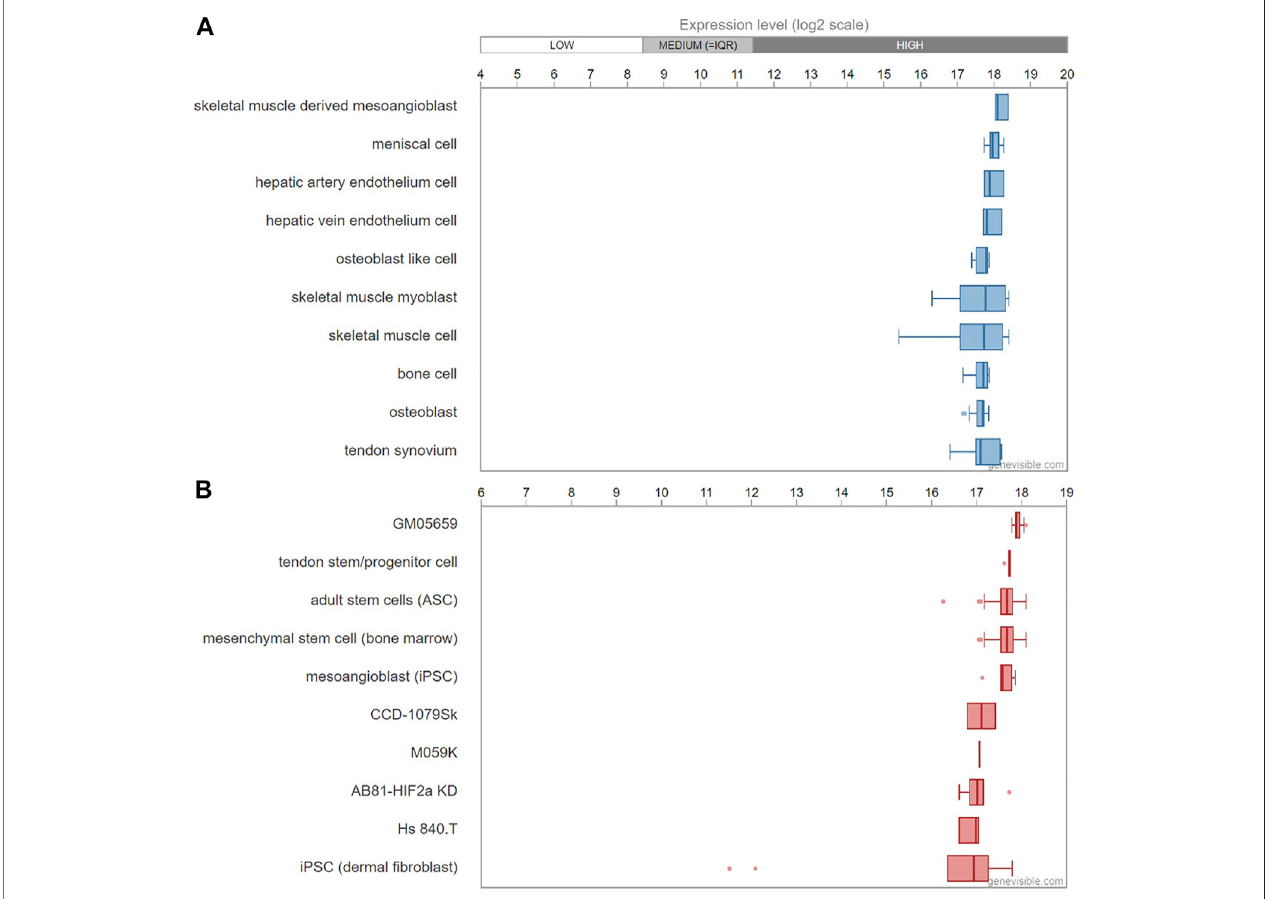
FIGURE 3 | mRNA expression pro fi ling of FBN1 gene in human tissues (A) and cell lines (B) predicted by Genevisible ® bioinformatics analyses (http://genevisible. com). The ten most highly ranking tissues and cell lines that express FBN1 mRNA are shown.